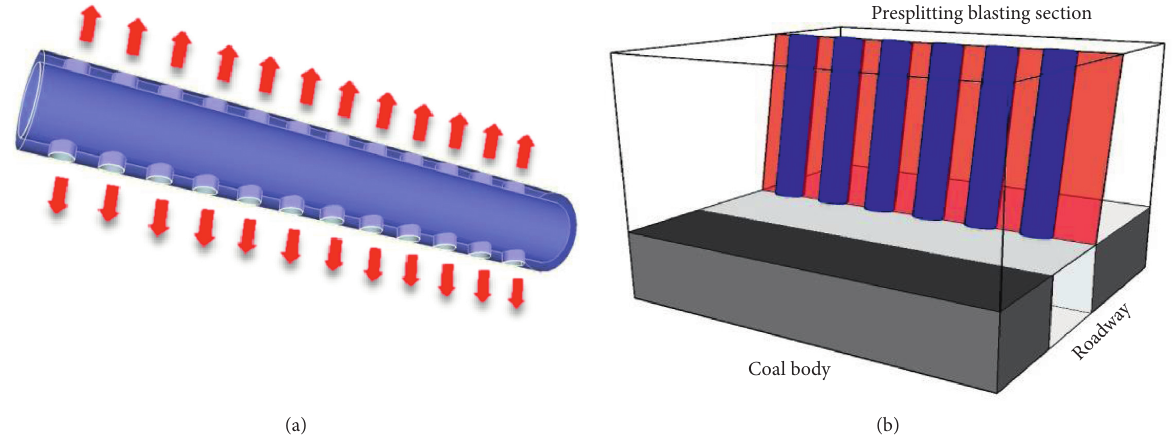
Figure 4: Bidirectional energy blasting technology. (a) Principle of bidirectional energy blasting. (b) Presplitting blasting the roof strata.